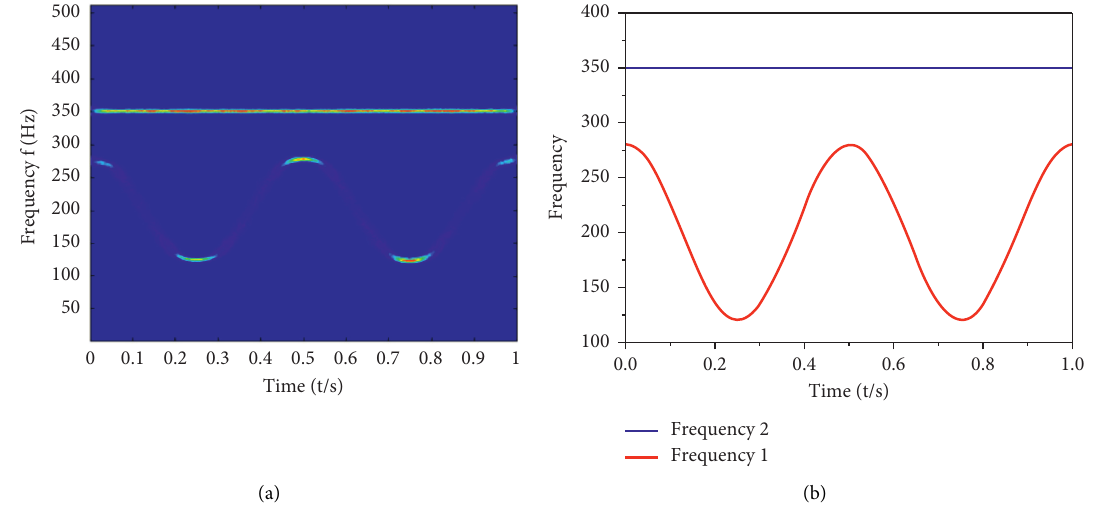
Figure 8: Metric matrix and the ridge lines obtained by the improved algorithm.